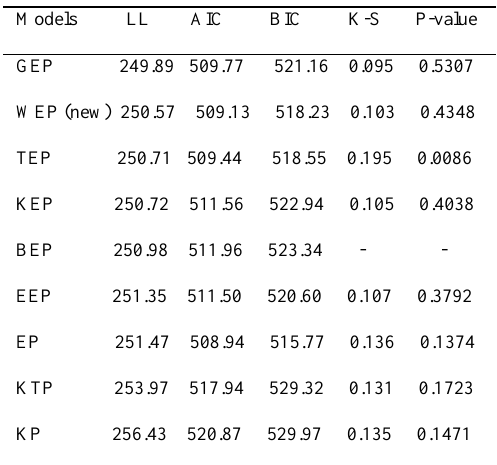
Fig. 5. The fitted densities of GEP with some competing models